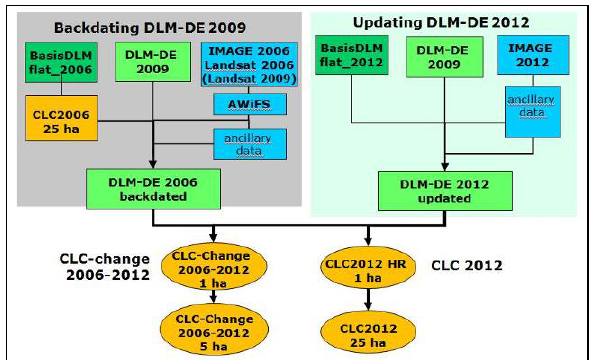
Figure 1: The two tasks of updating and backdating during the production of CLC2012 and CLC-change (2006 – 2012) showing also the related data flows. Source: Keil et al, 2015.